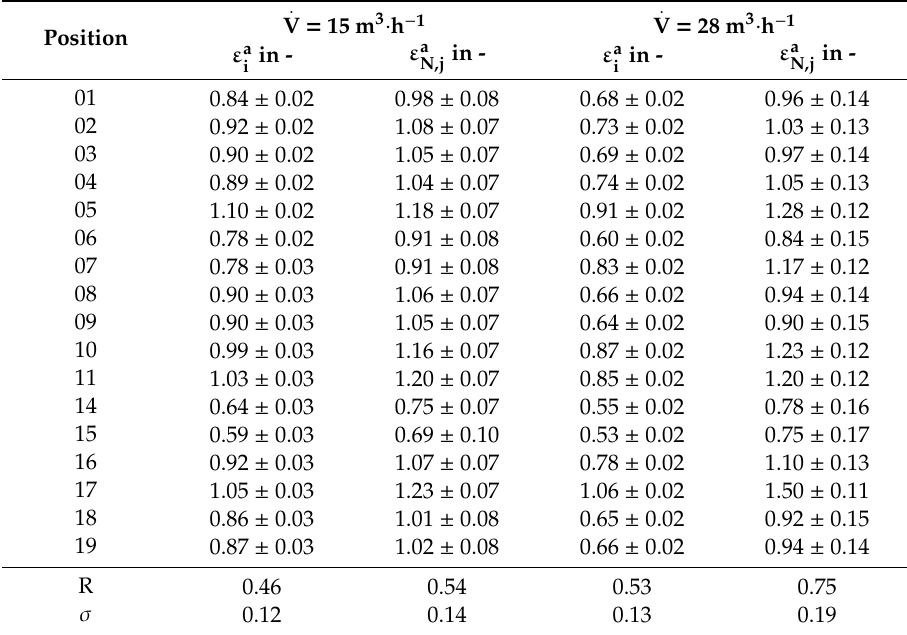
Table A3. Local air exchange at cold supply air